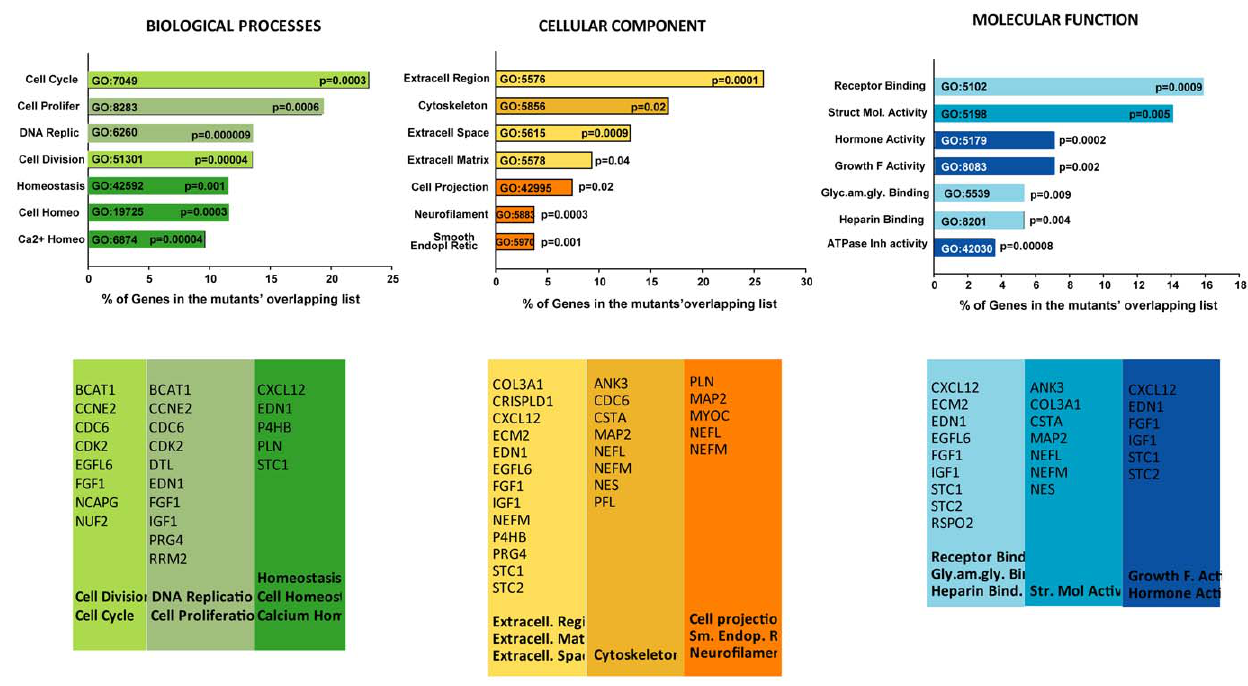
Figure 7. Gene ontology. The ECM category (GO:5576) contained the highest percent and significance of MYOC-induced genes. Top: e nriched GO categories of the 73 gene list shared by all mutants (from Figure 6) sorted by P values. Bottom : genes selected from the categories shown on top (color coded).